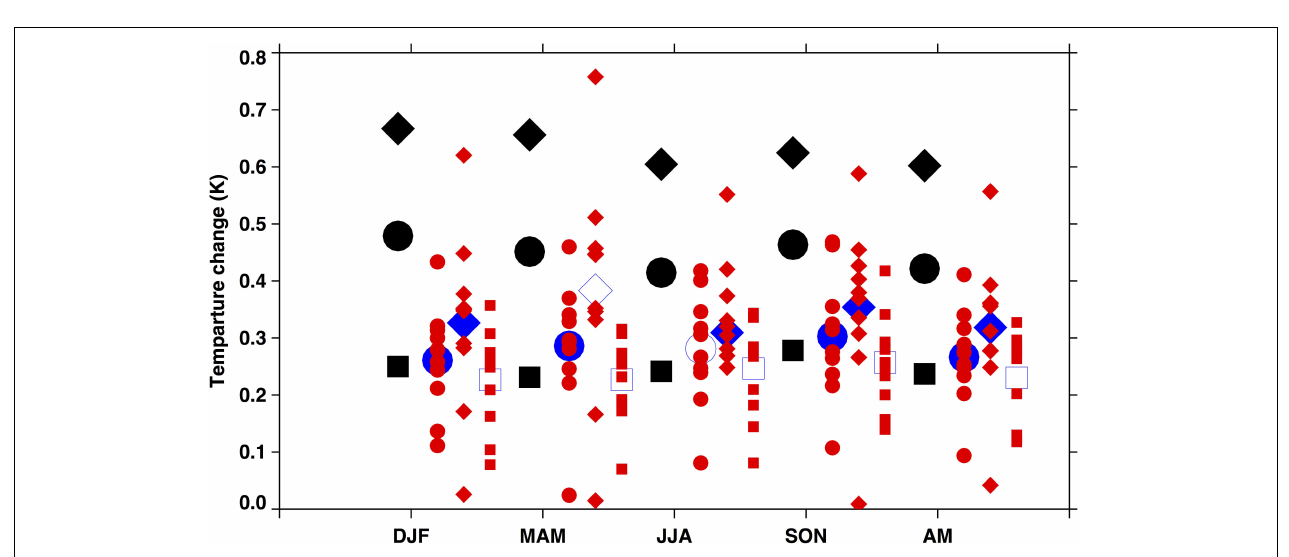
FIGURE 3 | Comparison of the simulated and reanalyzed global, annual, and seasonal mean surface air temperature trends for the period 1910–1940. CCC400 data are shown in black. The results of model run ALL for ensemble mean are shown in blue, while all ten individual members are shown in red. Global, Northern Hemisphere, and Southern Hemisphere mean trends are shown with circles, rhombuses, and squares. Filled large symbols mark the points where the simulated trends differ from observations with more than 95% statistical